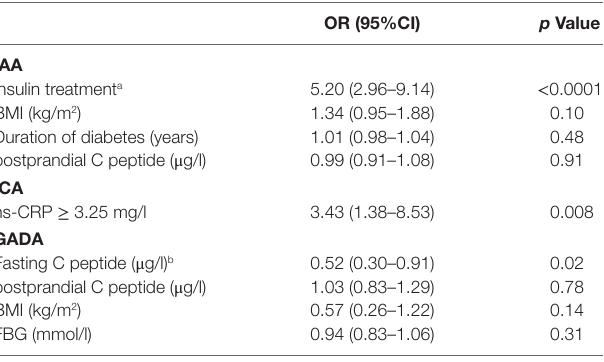
TaBle 4 | Binary logistic analysis of islet autoantibodies in elderly type 2 diabetes.